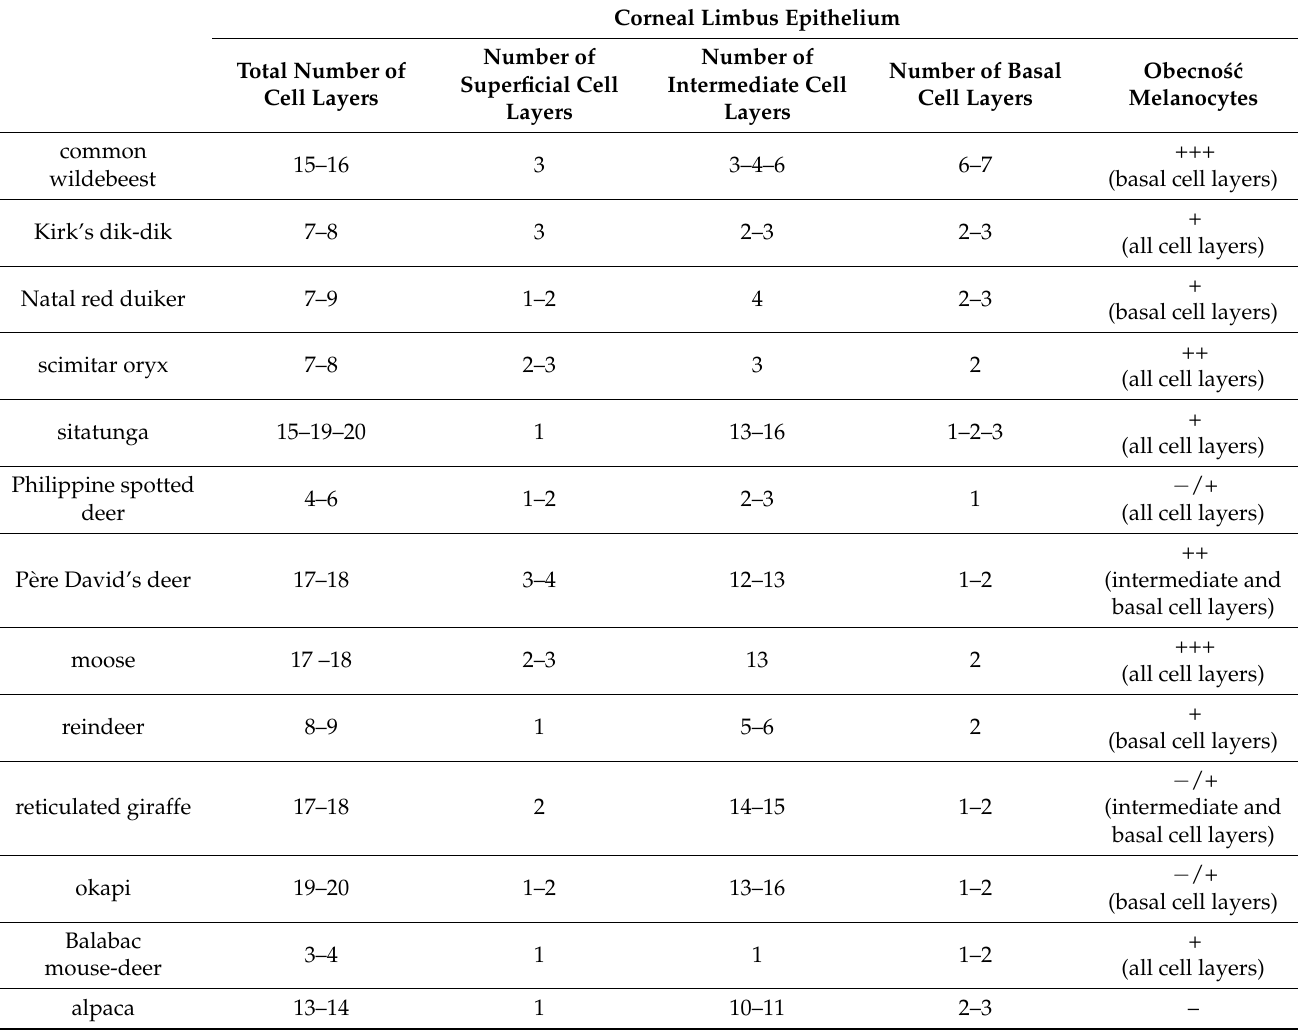
Table 4. Characteristic of the corneal limbus epithelium (palisades of Vogt) in the examined